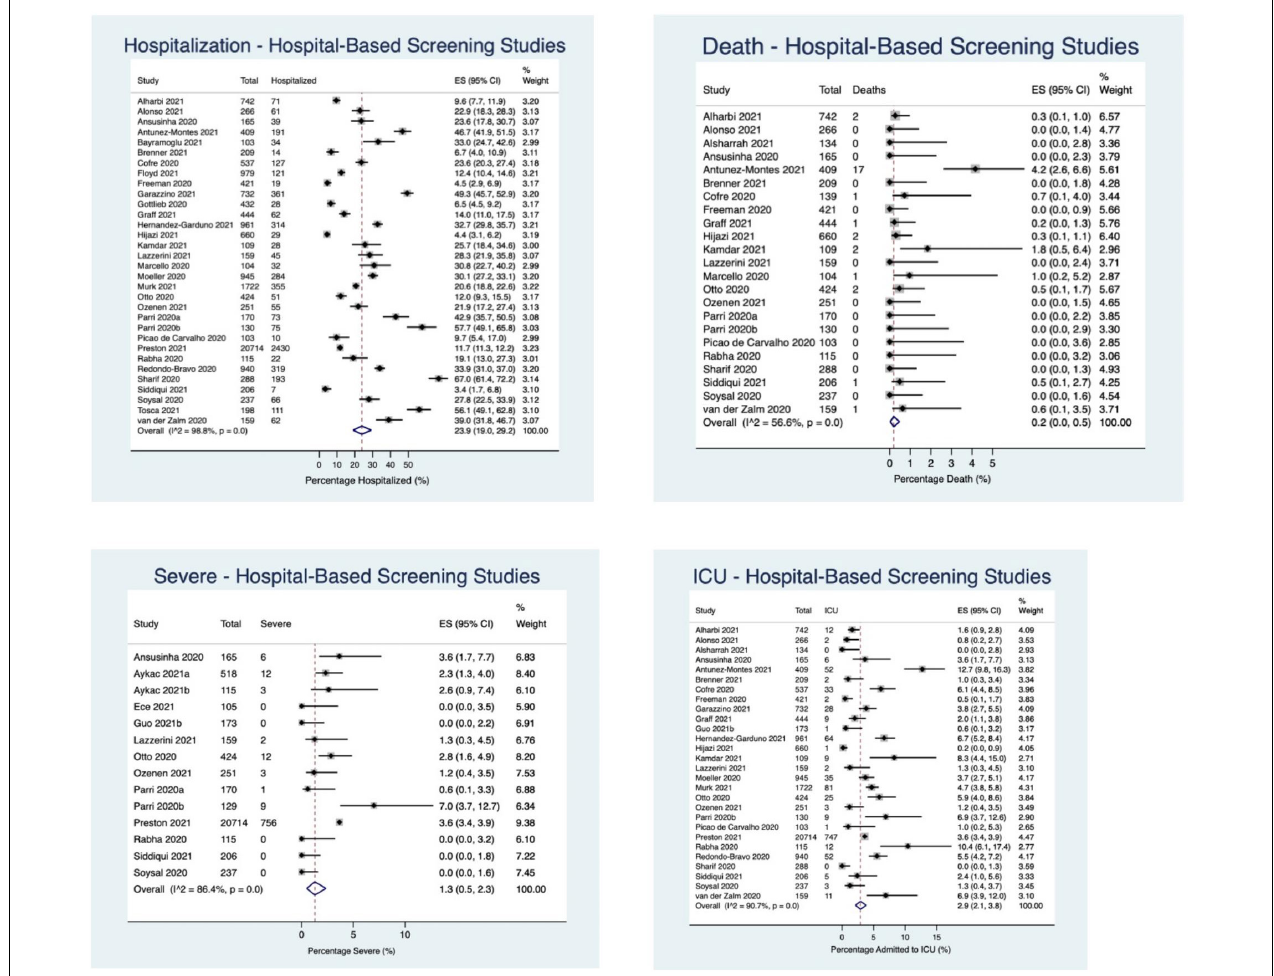
FIGURE 5 | Percentage of children experiencing outcomes in hospital-based screening